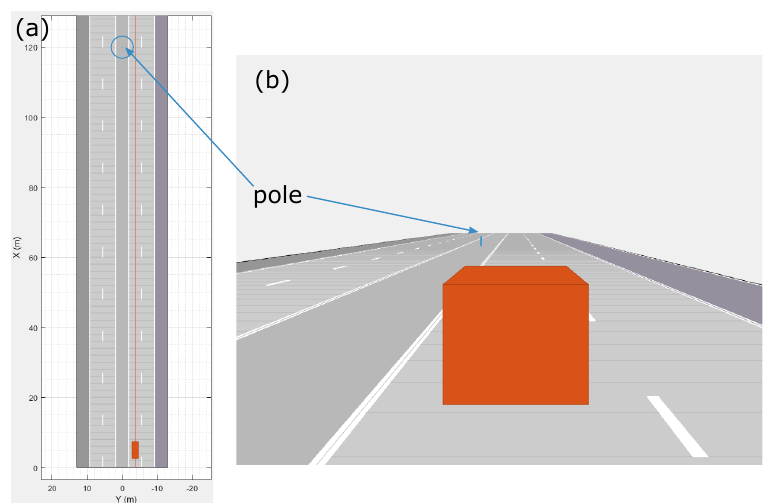
Figure 6. Highway simulation with a single pole: ( a ) bird’s-eye view; ( b ) ego-centric